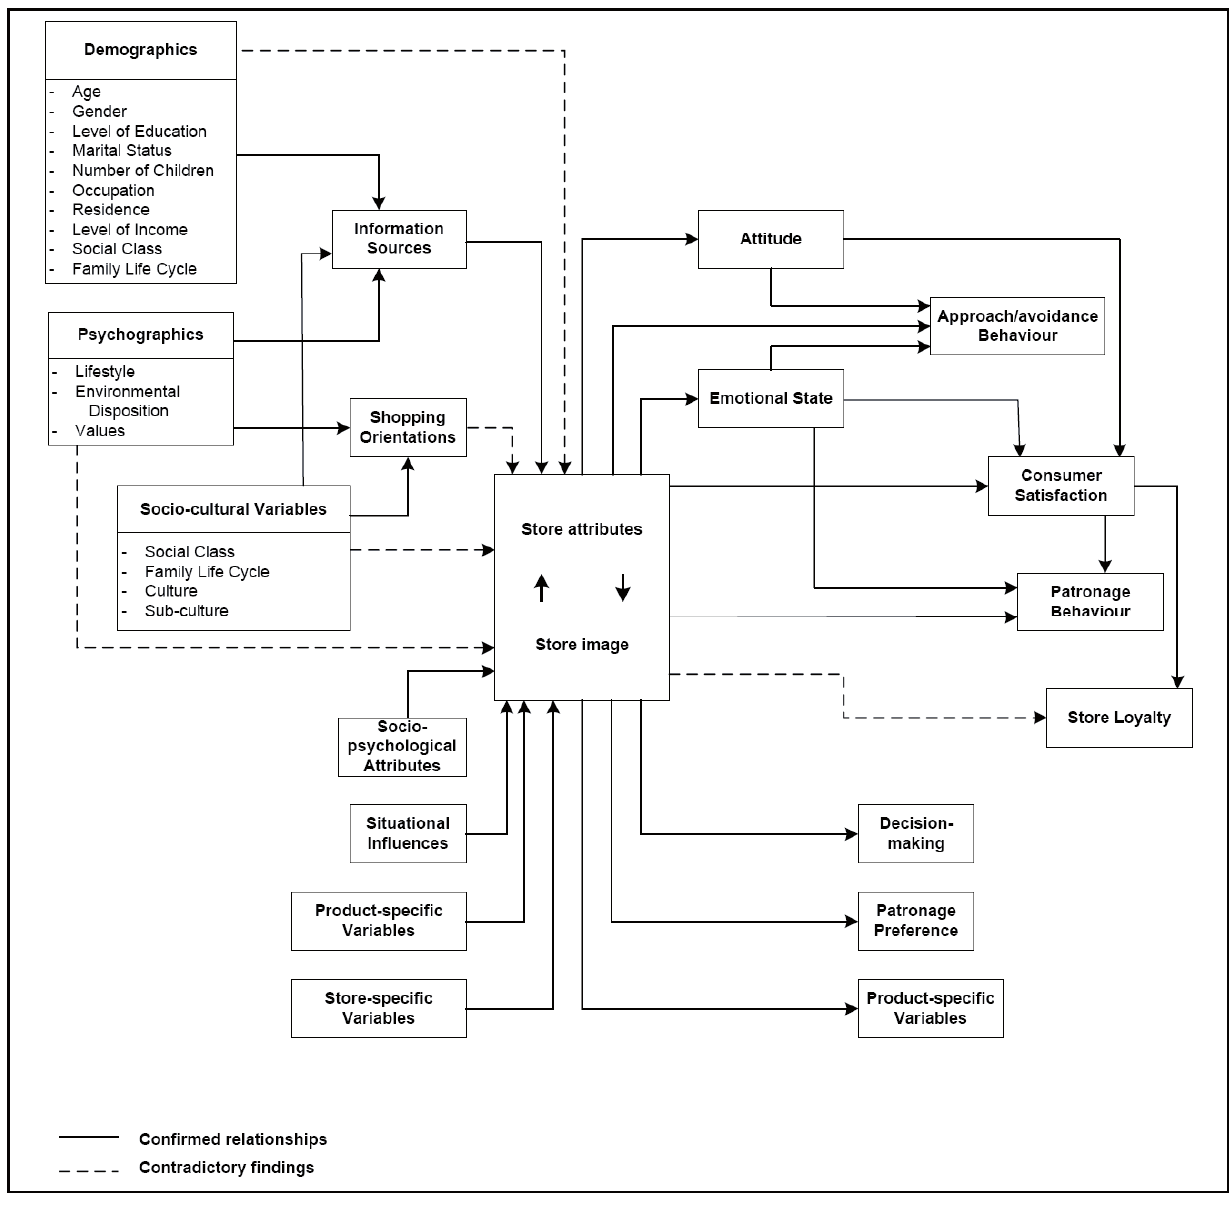
Figure 1 Proposed conceptual theoretical model of store image and related consumer behaviour